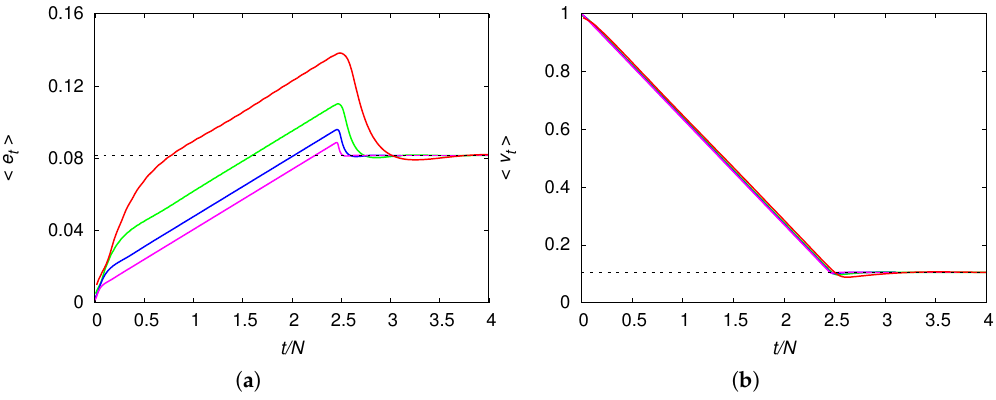
Figure 2. ( a ) Mean engineer density (cid:104) e t (cid:105) as function of the rescaled time t / N ; ( b ) Mean fraction of virgin habitats (cid:104) v t (cid:105) as function of the rescaled time t / N . The chain sizes are N = 51 (red line), N = 101 (green line), N = 201 (blue line) and N = 401 (magenta line). The model parameters are r = 1, α = 1, δ = 0.1, ρ = 0.01 and µ = 0.1. The fixed point solution e ∗ ≈ 0.0814 and v ∗ ≈ 0.1041 obtained from Equation (9) is shown by the dashed horizontal lines.